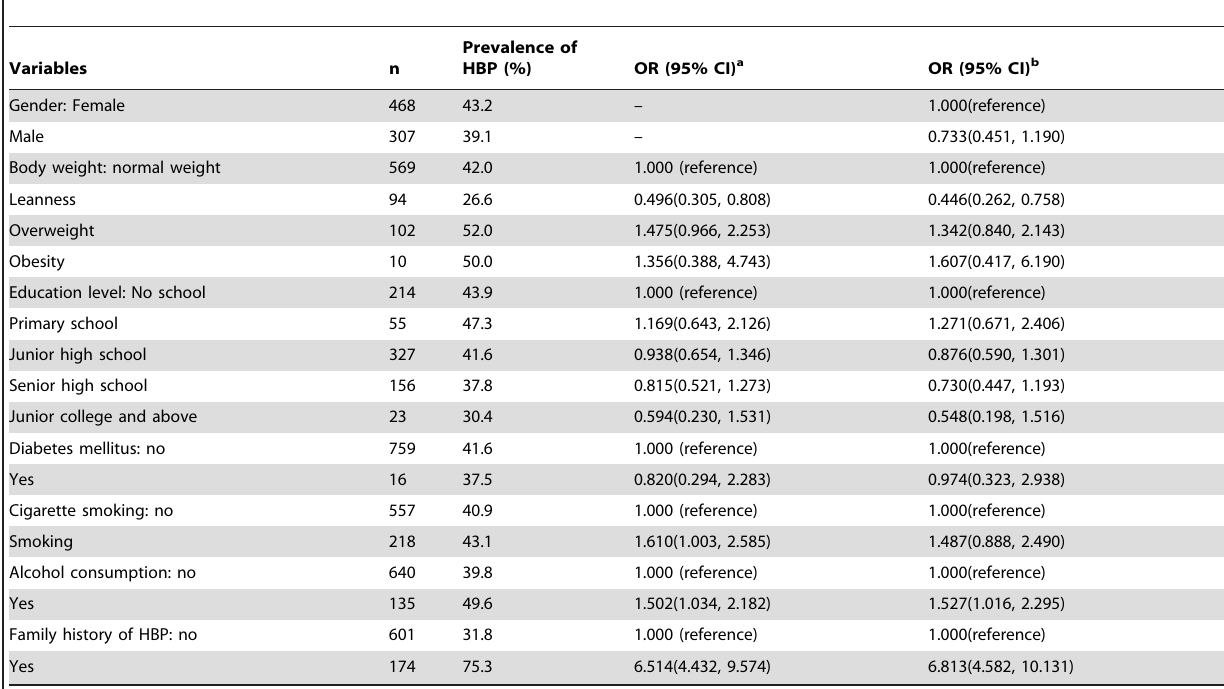
Table 5. Factors associated with the prevalence of hypertension from multivariate logistic regression models in age group 60–69 (N=